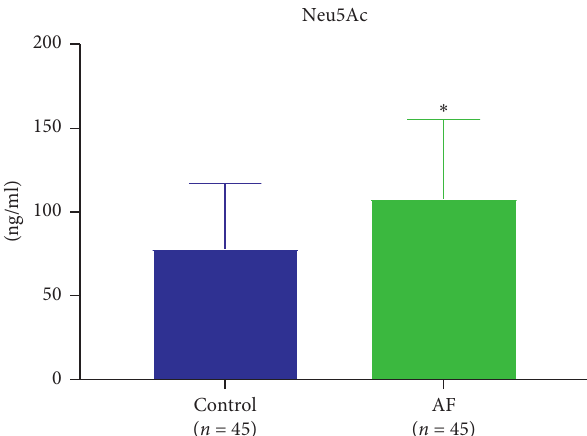
Table 2: Multivariate logistic regression analysis of risk factors for atrial fibrillation.